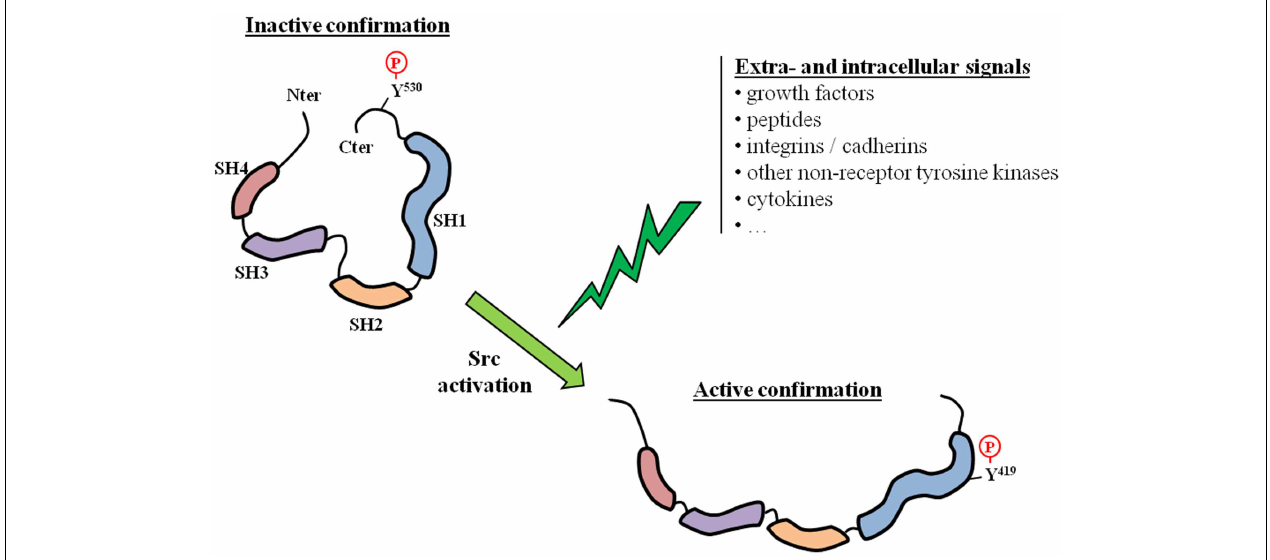
which is characteristic of the inactive state, to a tyrosine residue located in the catalytic SH1 domain (Y419). Src activation can result from various extra- and/or intracellular